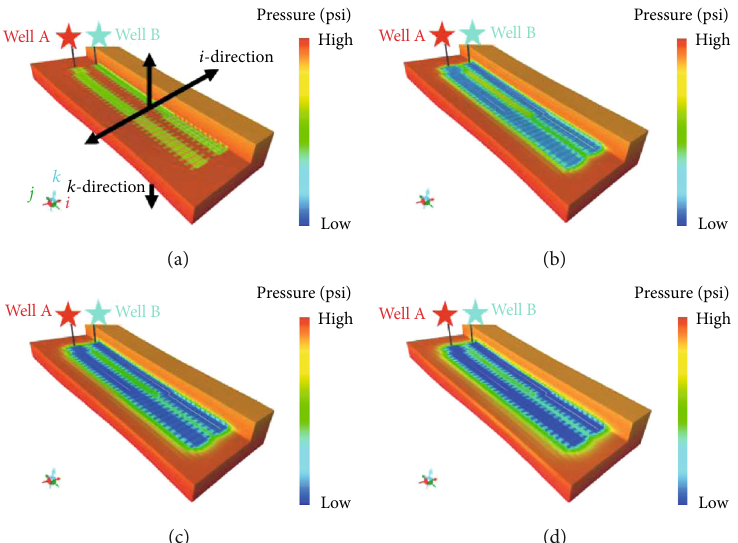
Figure 11: Reservoir depletion at di ff erent times: production after (a) 1 month, (b) 4 months, (c) 8 months, and (d) 12 months.